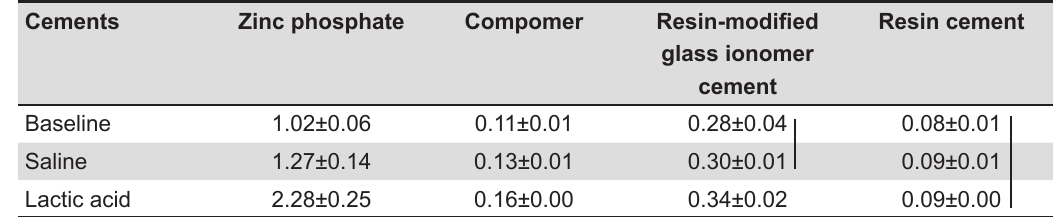
Table 1- Average roughness (µm) ± standard deviation distribution within groups, at baseline and at the 15 th day after immersion in saline or lactic acid solution